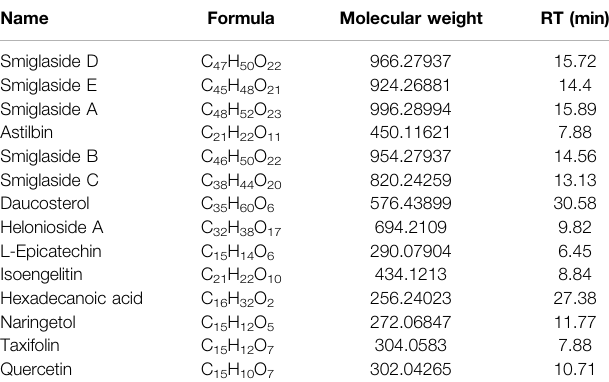
TABLE 2 | SGR-EA active substance